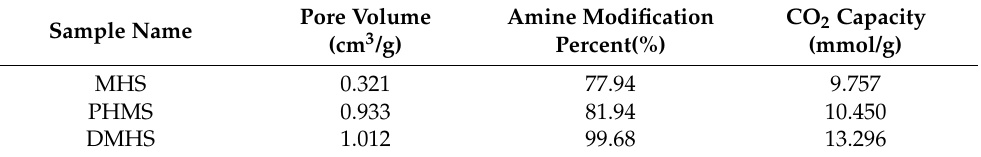
Figure 5. CO 2 adsorption performance of MHS, PHMS, and DMHS. Table 4. CO 2 adsorption amount according to pore volume and amine modification percentage.